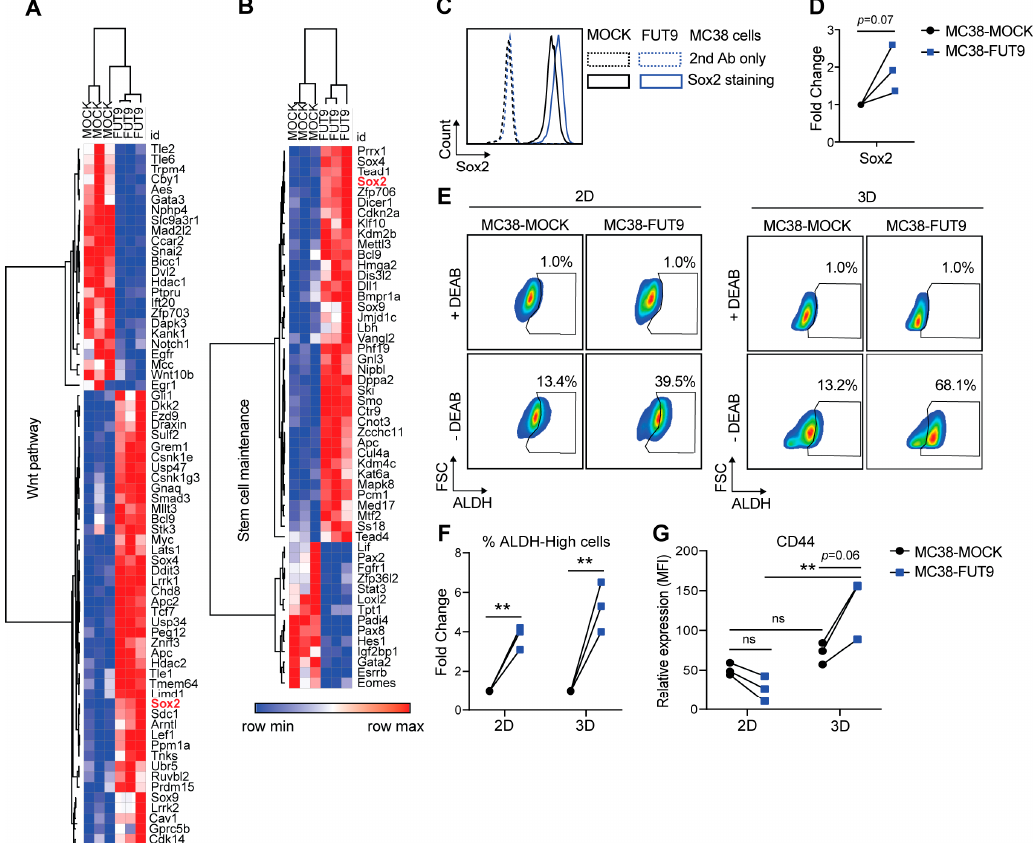
Figure 2. FUT9 neo-expression in MC38 cells results in an enhanced stem cell-like transcriptional profile and phenotype ( A , B ) Expression of DEGs associated with the Wnt pathway ( A ) or stem cell maintenance ( B ) in the MC38-MOCK and MC38-FUT9-expressing cells. Sox2 is highlighted in red. ( C ) Intracellular staining of Sox2 in MC38 cells using flow cytometry (left; n = 3). ( D ) Fold change in mean fluorescent intensity (MFI) of Sox2 in MC38-FUT9 cells compared to MC38-MOCK cells ( n = 3). Statistical significance was determined by an unpaired Student’s t test. ( E ) ALDH activity in MC38-MOCK and MC38-FUT9 cells cultured either in 2D (left panel) or 3D (right panel), measured using the ALDEFLUOR assay. The DEAB inhibitor of ALDH was used as a control for gating and further analysis of the percentage of ALDH-High cells in each condition. Dotplots are representative of three independent experiments. ( F ) Fold change in the percentage of ALDH-High cells in the MC38-glycovariants upon 2D ( n = 3) or 3D ( n = 3) cultures (relative to MC38-MOCK cells). Statistical differences were determined by an unpaired Student’s t test (** p < 0.01). ( G ) Relative expression (MFI) of CD44 in MC38 cells cultured in 2D ( n = 3) or 3D ( n = 3). Statistical significance was determined by a one way ANOVA (ns; no significance, ** p < 0.01).